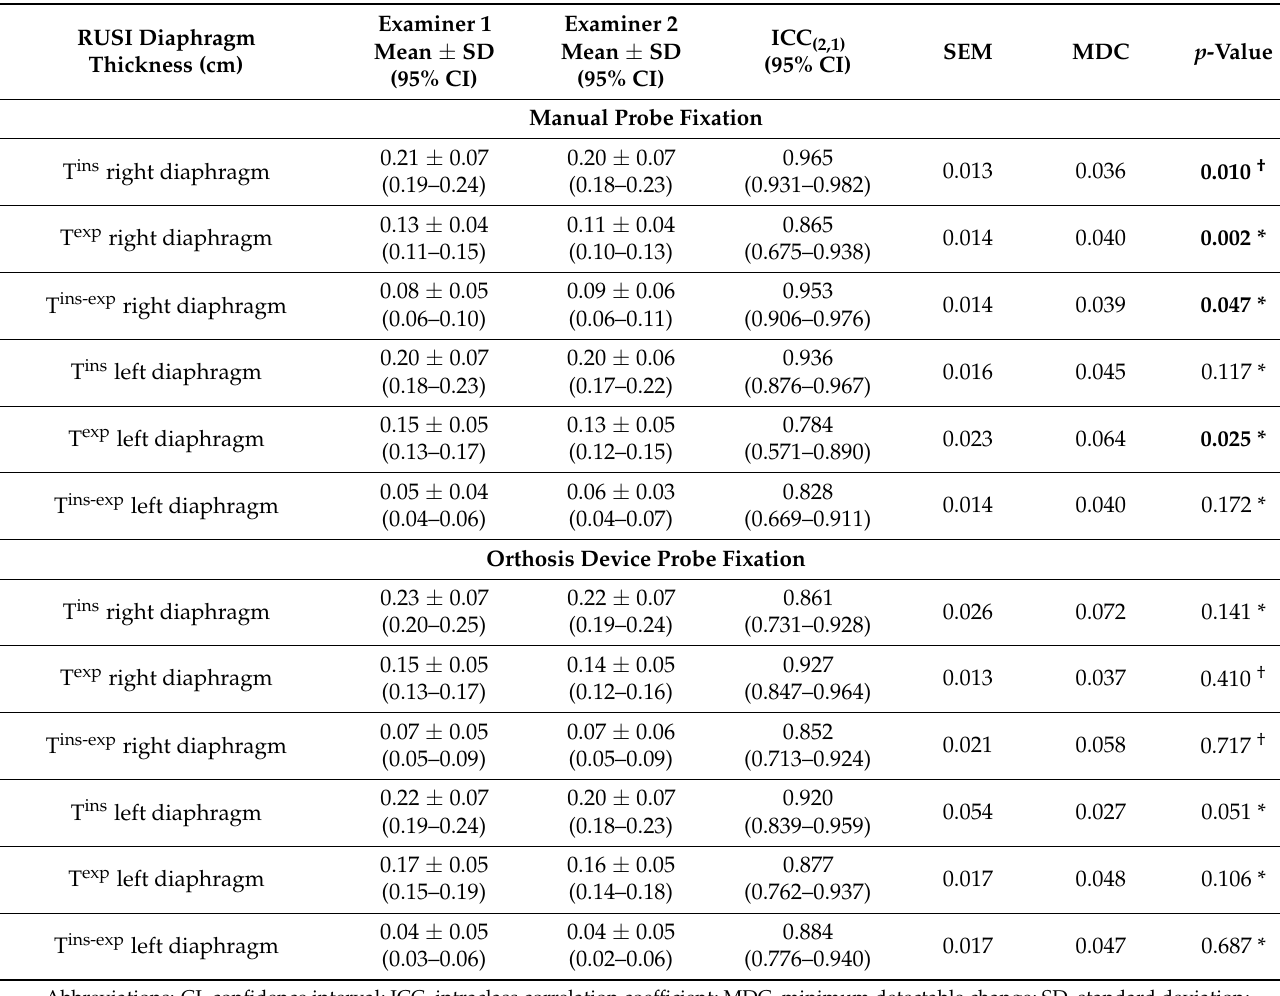
Table 4. Inter-rater and inter-session reliability analysis for RUSI diaphragm thickness within both manual and specific orthosis device measurement methods during relaxed